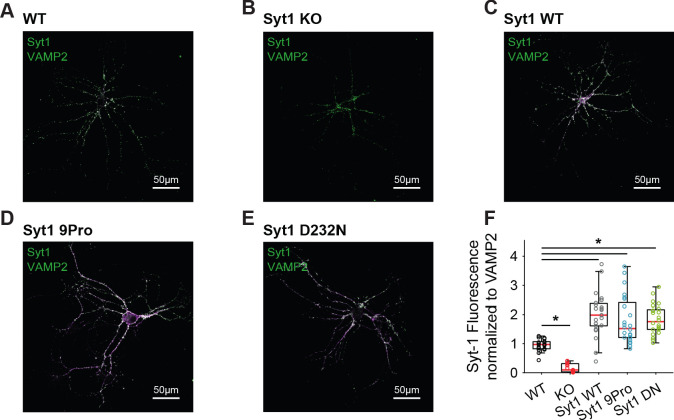
Synaptic expression of Syt1 WT and mutant rescue constructs exceeds endogenous levels.Representative examples of (A) WT, (B) Syt1 KO, (C) Syt1 WT expressing, (D) Syt1 9Pro expressing, and (E) Syt1 D232N expressing autapses stained for Syt1 (magenta) and the synaptic marker VAMP2 (green). (F) Boxplots of Syt1 fluorescent intensity, normalized to VAMP2 intensity. (*p<0.05, Wilcoxon rank sum test).
Figure 2—figure supplement 1—source data 1.Statistics overview.